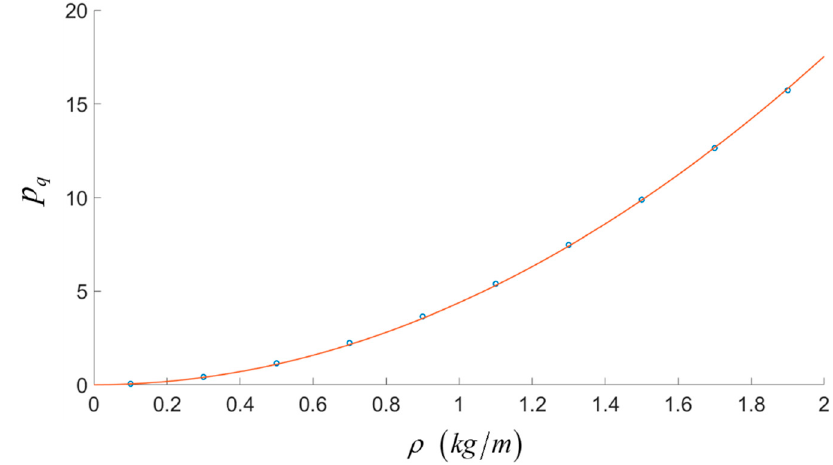
β q with different ρ . and a